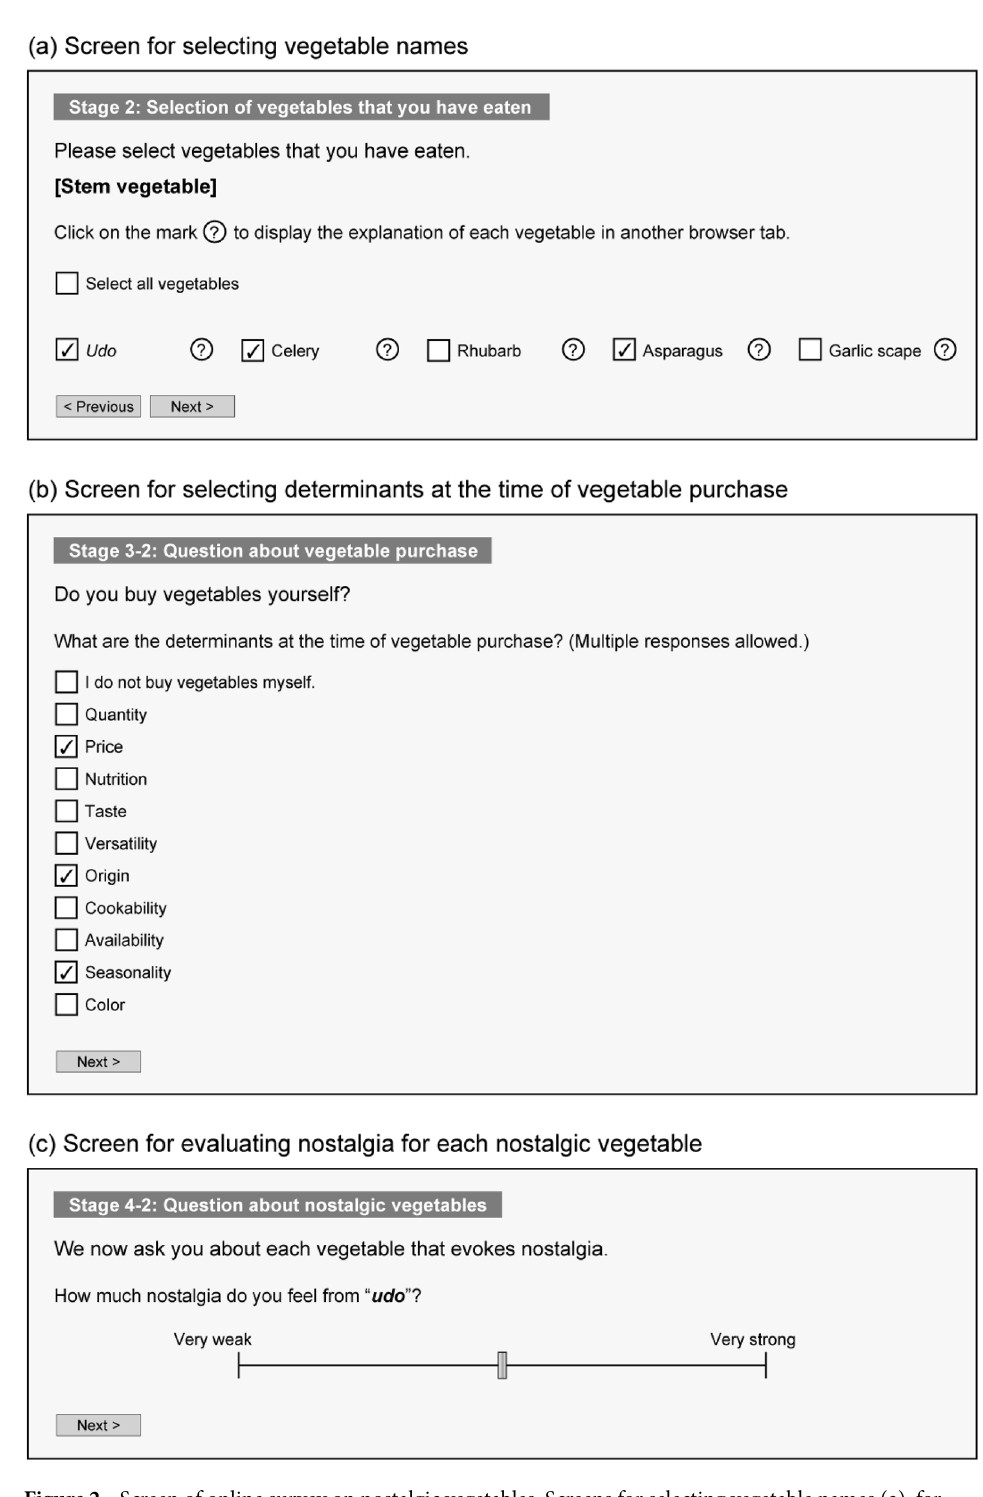
Figure 2. Screen of online survey on nostalgic vegetables. Screens for selecting vegetable names ( a ), for selecting KBFs at the time of vegetable purchase ( b ), and for evaluating various psychological characteristics of nostalgic vegetables ( c ). In ( a ) and ( b ), the participant answered questions by selecting the applicable checkboxes. In addition, in ( a ), when the participant clicked the boxed question mark placed after the vegetable name, another browser tab displayed a brief explanation of that vegetable and its picture. In ( c ), evaluation value was expressed by moving the slider along a visual analog